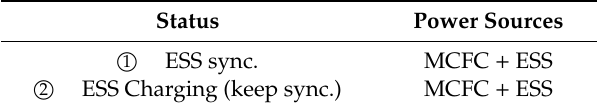
Figure 14. Synchronization and system deviation for load pattern of normal seagoing case 2.